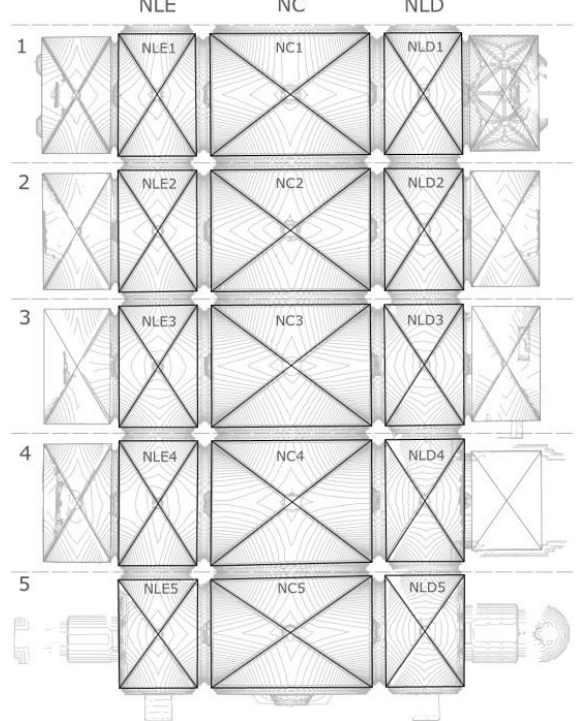
Figure 4. Topography and nomenclature of